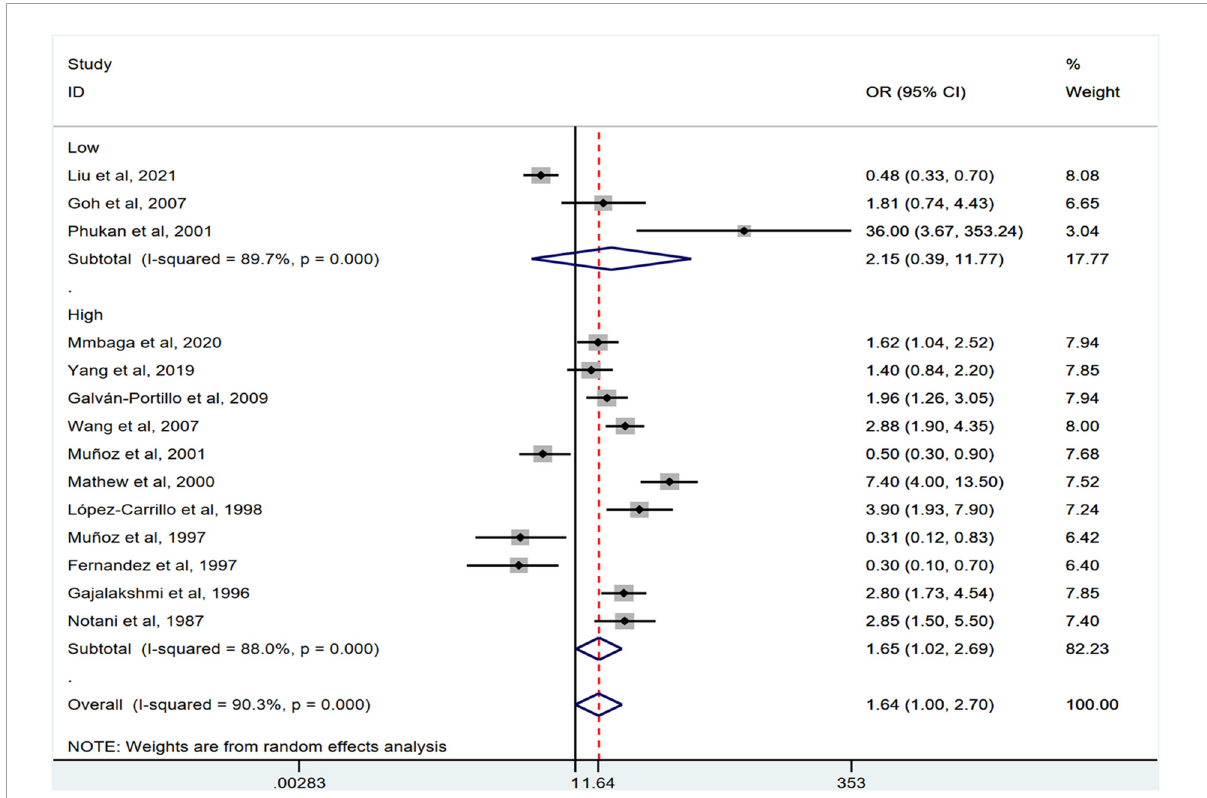
FIGURE7 Subgroup analysis showing associations between chili pepper consumption and the risk of GI cancers based on the study quality. OR, odds ratio; CI, confidence